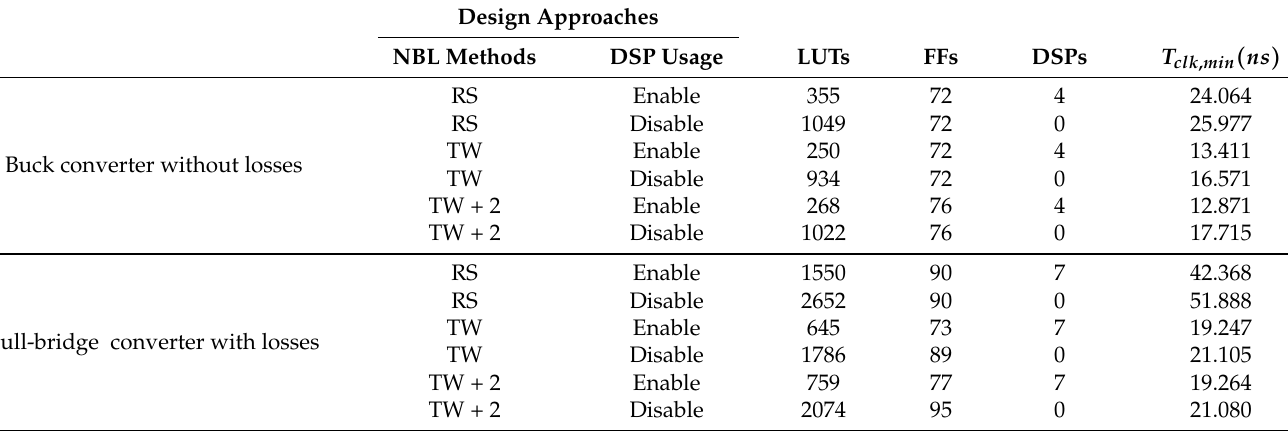
Table 4. VHDL-2008 synthesis results for fixed-point using Vivado